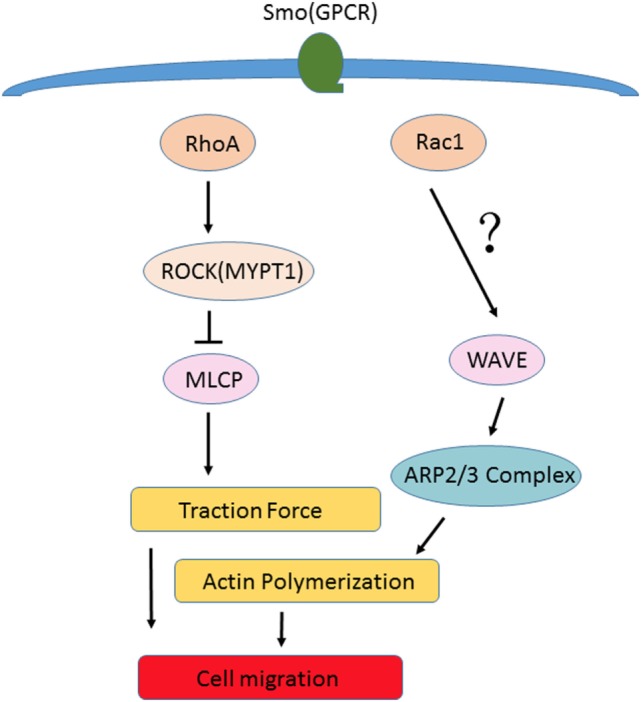
Non-canonical signaling pathway of Shh. By coupling of G protein-coupled receptors, Smo modulates the activation of RhoA/ROCK (MYPT1) signaling through increasing/decreasing MLCP level to enhance/weaken traction force, which results in promoting/reducing rheumatoid arthritis (RA)-fibroblast-like synoviocytes (FLSs) migration. On the other side, Rac1 induces actin polymerization to promote RA-FLSs migration through its downstream protein such as WAVE/ARP2/3 complex. It is likely that Smo serves as a principal mediator of cytoskeletal tension in the process of cell migration.